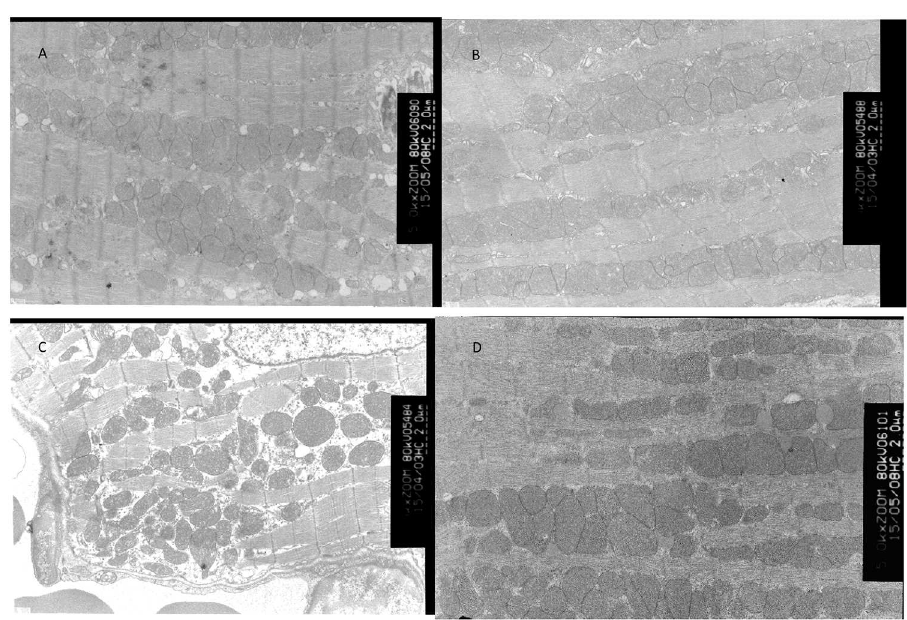
Fig 7. Representative electron microscopy images of cardiac mitochondria of each of the four groups. (A) Control group mice were pretreated with saline and then received saline 5 min later. (B), (C), (D) Mice were pretreated saline, 0.1 mg/kg of isoprenalin or 5 mg of esmolol, respectively, and then received 46.7 mg/kg of bupivacaine 5 min later. Arrows indicate focal high-amplitude matrix swelling.